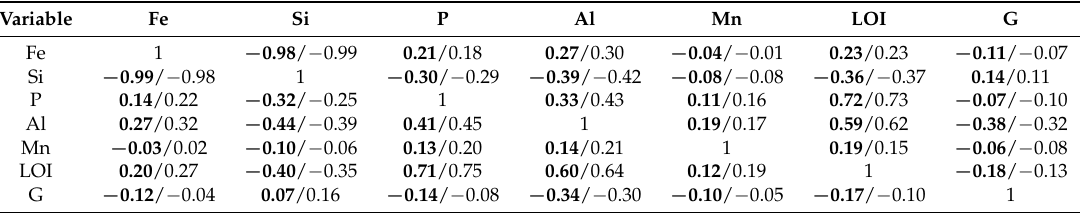
Table 2. Correlation coefficients of drill hole data and simulated outcomes of grades and granulometry (correlation observed on drill hole data: bold entries above main diagonal; average correlation over 20 outcomes: regular entries above main diagonal; minimum correlation over 20 outcomes: bold entries under main diagonal; maximum correlation over 20 outcomes: regular entries under main